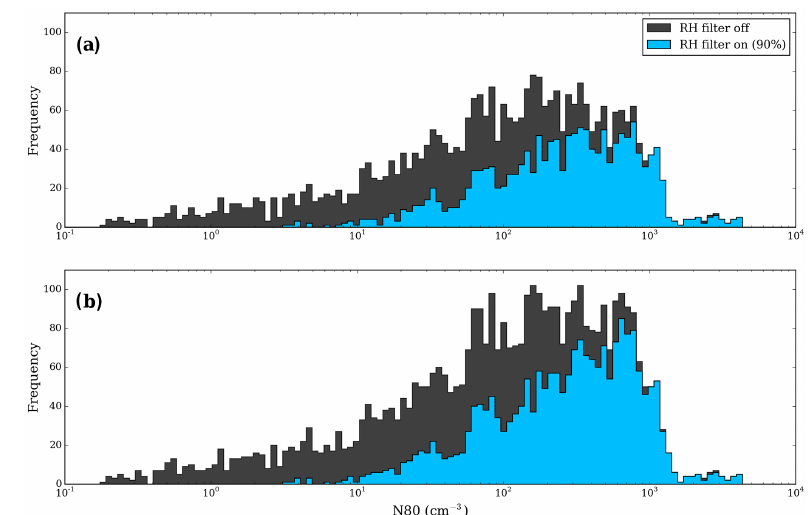
Figure 4. Histogram of the frequency of data points as a function of measured N80 (the total number of particles with particle diameter, D p , > 80nm), for (a) coarse simulations (4 ◦ × 5 ◦ ) and (b) nested simulations (0.5 ◦ × 0.667 ◦ ). The dark-gray bars are with the relative humidity filter off and the blue bars are with the 90% relative humidity filter applied.